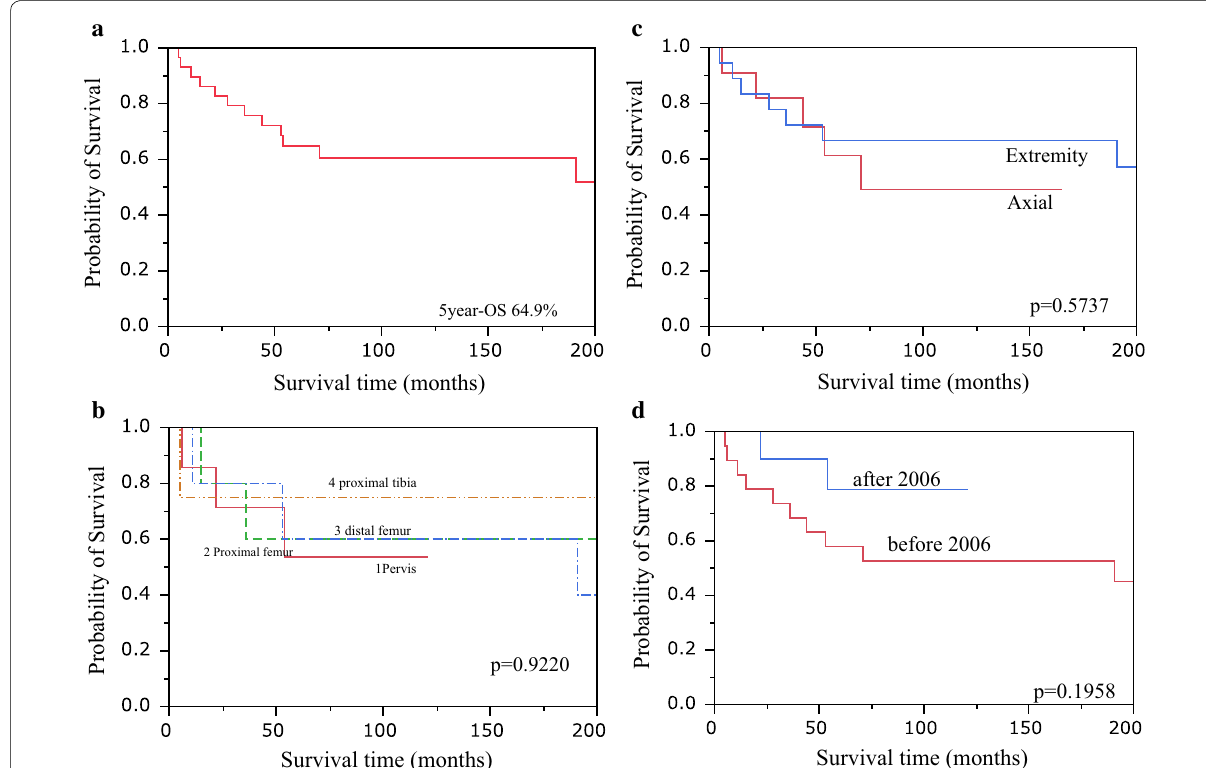
Fig. 1 Overall survival. a The 5-year overall survival (OS) was 64.9%. b The 5-year survival rates for each location were 53.6% for the pelvis, 60.0% for the proximal femur, 60.0% for the distal femur, and 75.0% for the proximal tibia. c There was no significant difference between the 5-year survival rate for the trunk at 61.4% and that for the extremities at 66.7% (log-rank test, P 0.5737). d The 5-year survival rate improved to 78.8% from 57.9% = (log-rank test, P =